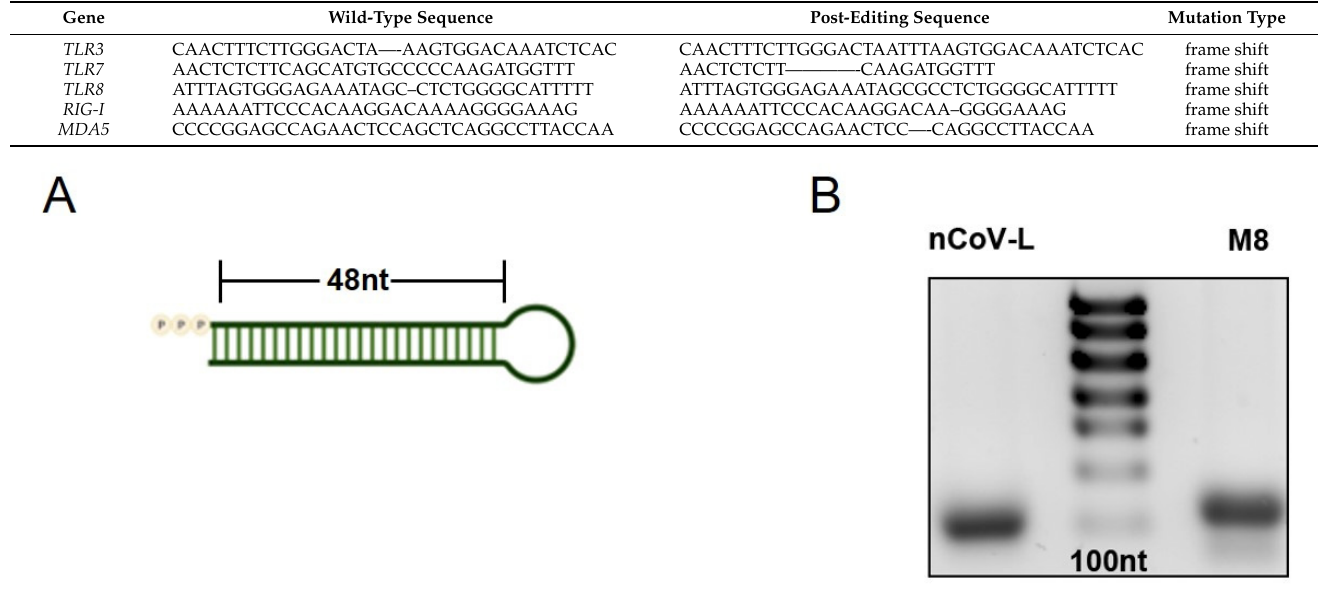
Figure A1. Features of nCoV-L. ( A ) Schematic diagram of secondary structure of nCoV-L was predicted using the RNAfold Webserver. The loop is 4 nt and the stem is 96 nt. ( B ) In vitro transcribed nCoV-L and M8 were purified, and then run on a TAE gel with denaturing buffer.